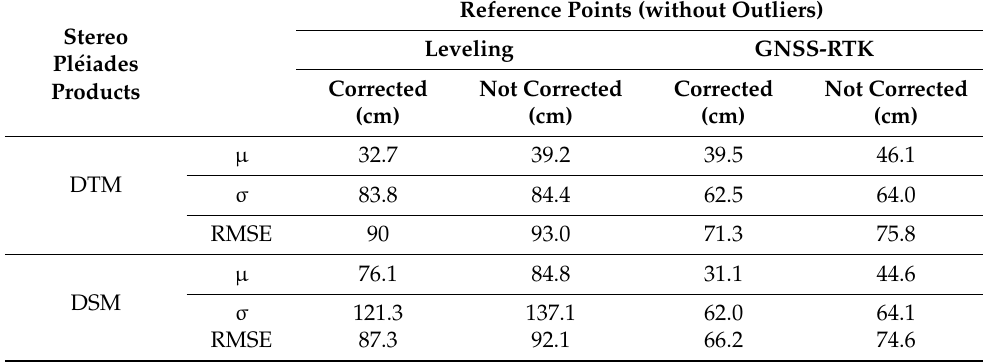
Table 5. The residuals of the 57 leveling points and 136 GNSS-RTK points for two scenarios: uncor- rected GNSS-RTK measurements and corrected GNSS-RTK measurements with the surface of the local quasigeoid and using the LR ALS-DTM in the image matching process (without